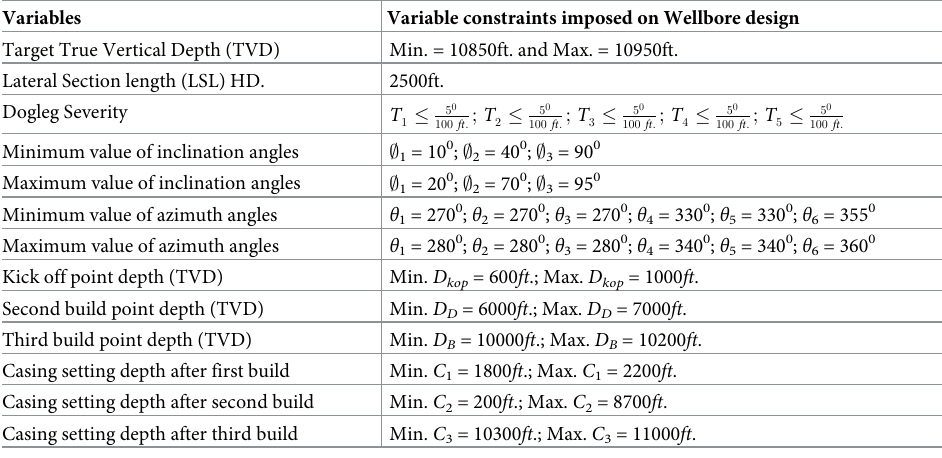
Variables Variable constraints imposed on Wellbore design Target True Vertical Depth (TVD) Min. = 10850ft. and Max. = 10950ft. Lateral Section length (LSL) HD.